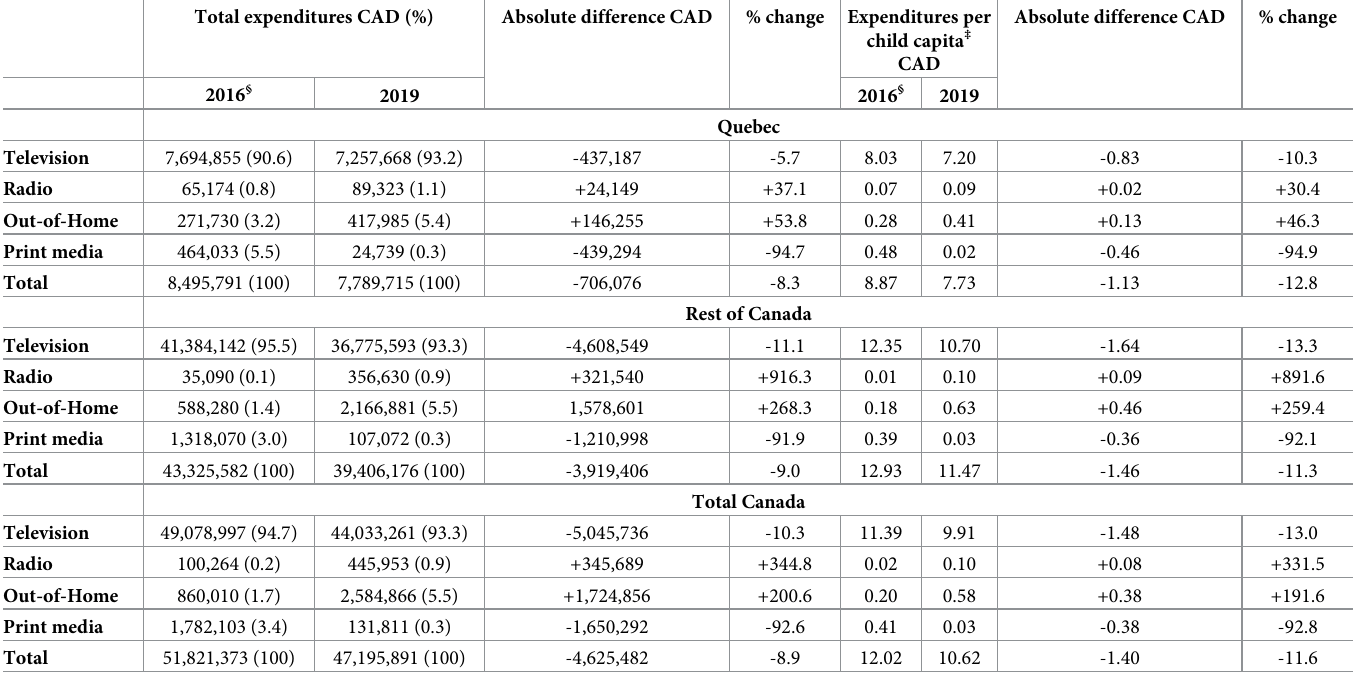
Table 5. Advertising expenditures on child-targeted products † in 2016 and 2019, by geographic area and media (excluding